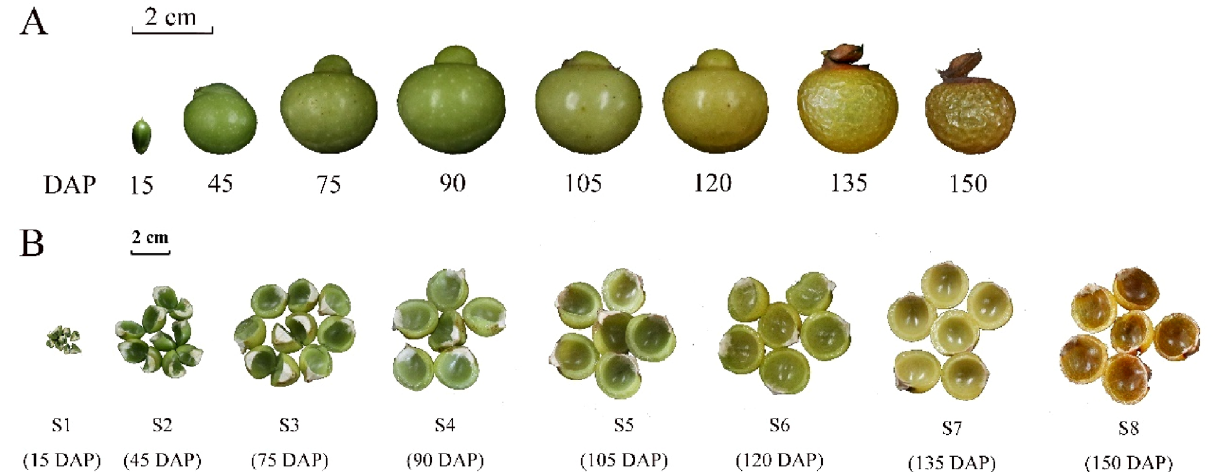
Figure 1. Soapberry sample from eight different fruit growth stages. This classification is based on the fruit development and fruit ripening: S1, early ovary development (15 DAP); S2, 30% of the biggest fruit size (45 DAP); S3, 70% of the biggest fruit size (75 DAP); S4, 80% of the biggest fruit size (90 DAP); S5, 90% of the biggest fruit size (105 DAP); S6, beginning of maturity (120 DAP); S7, great change in pericarp (135 DAP); S8, fully developed and mature (150 DAP). ( A ) Soapberry fruit; ( B ) soapberry 2.0–4.0 min (0–15% B), 4.0–14.0 min (15–32% B), 14.0–19.0 min (32–50% B), 19.0–19.1 min (50–100% B), 19.1–21.0 min (100% B), 21.0–21.1 min (100–0% B), and then initial conditions were maintained for 5 min